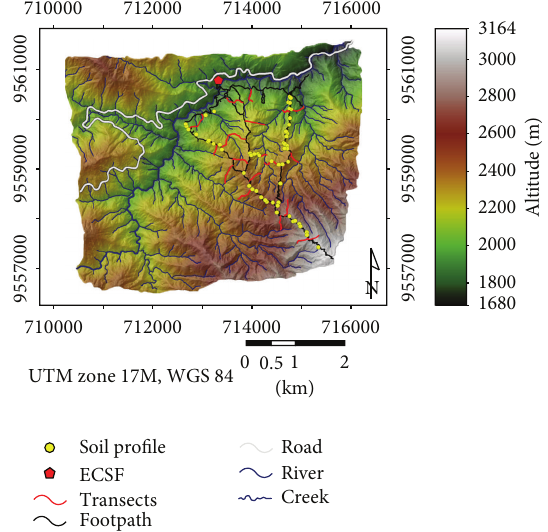
Figure 1: Sampling positions (adapted from [20]; overlaid hill shading with light source from